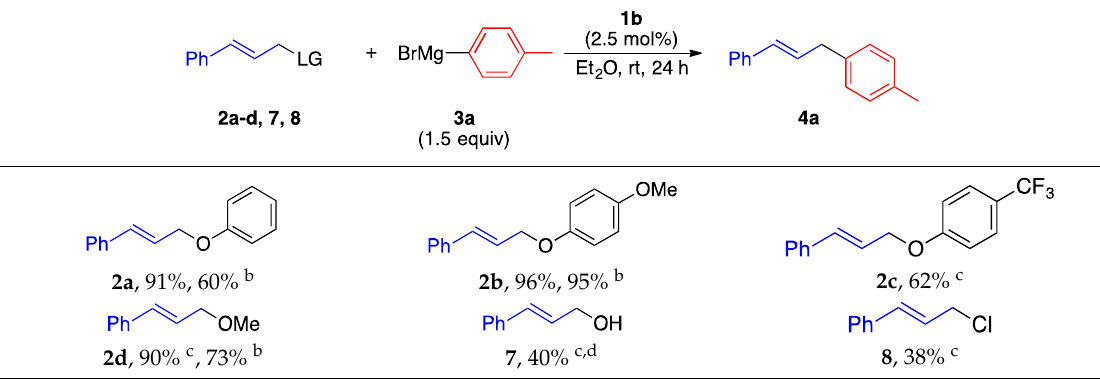
Table 3. The effect of the leaving group (LG) on the cinnamyl electrophiles.